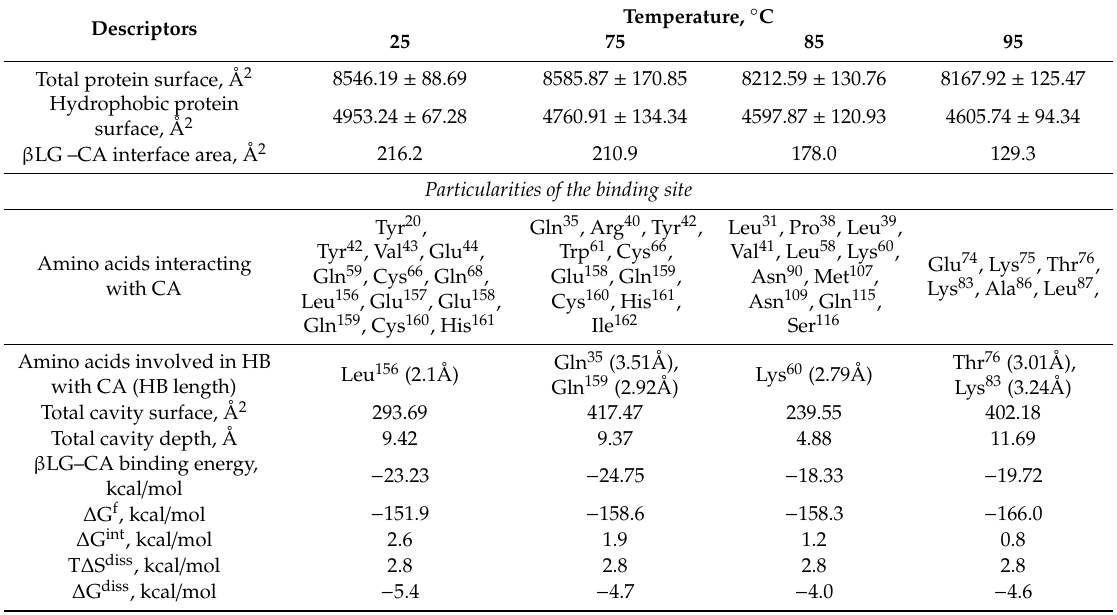
Table 3. Single molecule level details on the interaction between β -lactoglobulin ( β -LG) equilibrated at di ff erent temperatures and ca ff eic acid